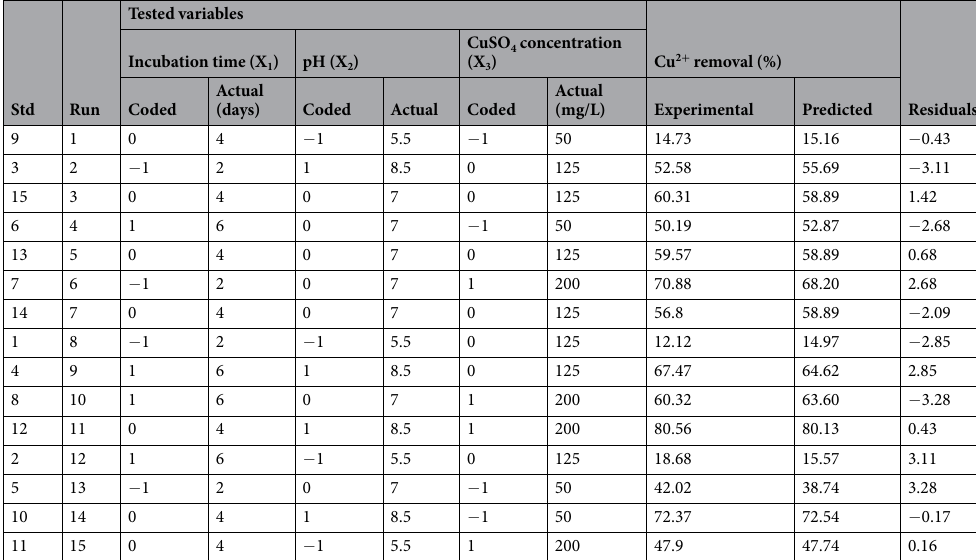
Table 1. Experimental fermentation conditions of the tested variables based on Box-Behnken design and the corresponding observed and fitted Cu 2 + removal % by Azotobacter nigricans NEWG-1.